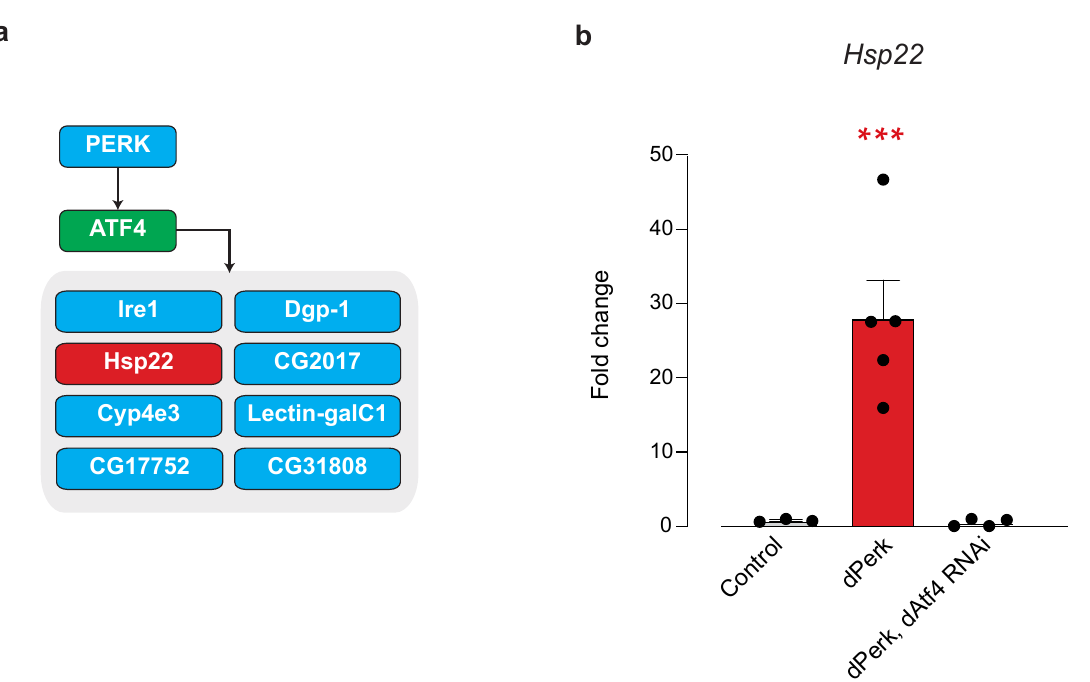
Figure 6. Mitochondrial chaperone Hsp22 is a target of dPerk/Atf4 signalling. ( a ) iRegulon analysis of group 1 genes suggests ATF4 (green) as a transcriptional regulator of Hsp22 (red). Blue squares denote group 1 genes characterised by an upstream ATF4 binding motif. ( b ) Hsp22 mRNA induction is regulated by dPerk and dAtf4. Expression levels were measured by real-time qPCR (mean ± SEM; asterisks, one-way ANOVA with Tukey’s multiple comparison test). Genotypes: Control: tub Gal80; da Gal4 > +, dPerk: tub Gal80; da Gal4 > dPerk -HA, dPerk, dAtf4 RNAi: t ub Gal80; da Gal4 > dPerk -HA, dAtf4 RNAi. Adult flies were heat-shock for 15 h at 29 ◦